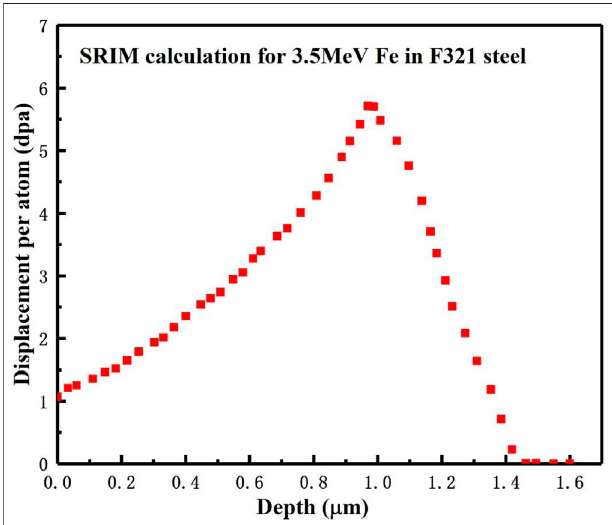
FIGURE 1 | Displacement damage pro fi le versus the depth that was calculated by the SRIM